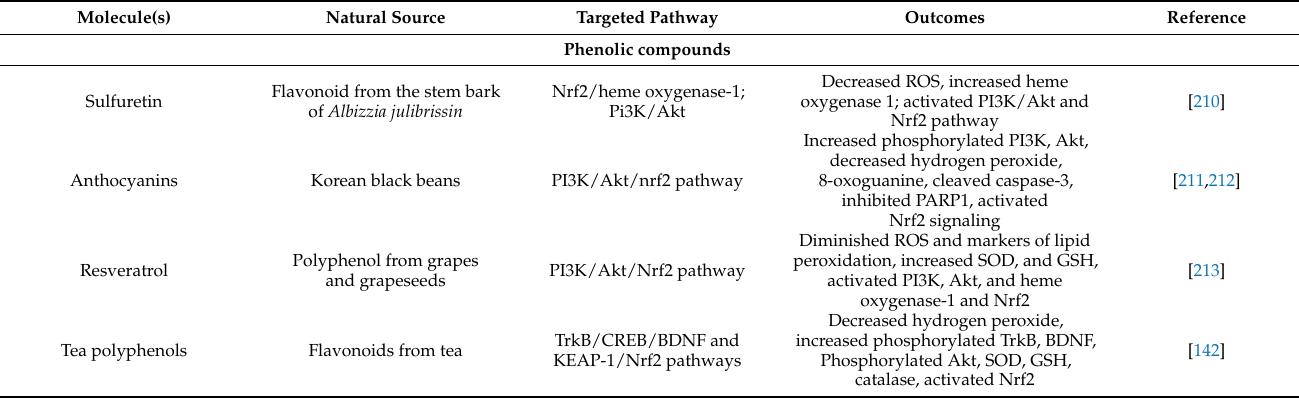
Table 2. Mechanism of action of phytochemicals with antioxidant